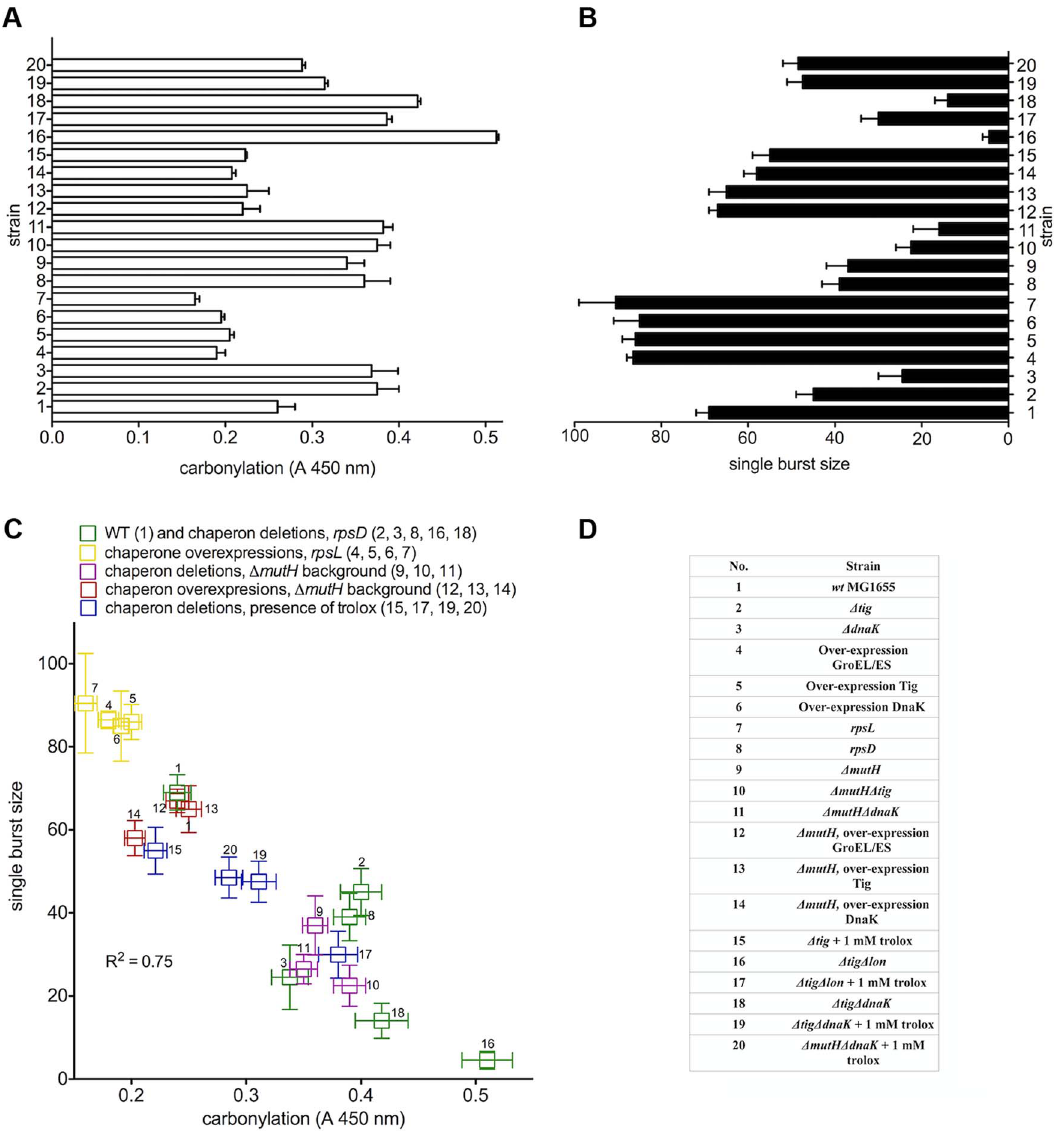
Figure 1. Proteome carbonylation correlates with cellular biosynthetic capacity. Exponentially growing E.coli strains with different levels of chaperone activity and translation errors show different levels of (a) protein carbonylation and (b) bacteriophage l single burst size. (c) ( x ) There is a negative correlation between total proteome carbonylation and biosynthetic capacity measured as single burst size of bacteriophage l . Strain identity corresponding to the numbers is listed in (d). Results are means of 3 measurements, each in triplicate. The error bars represent the standard deviation. R 2 value of the linear fit is indicated in panel (c). ‘‘Oe’’ stands for over-expression.